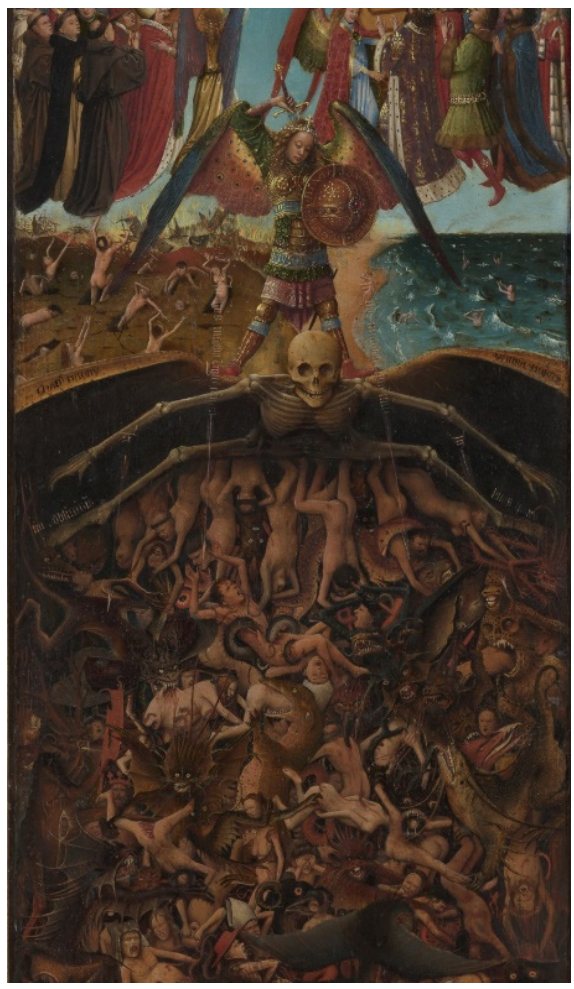
Figure 7. Detail of Figure 1.